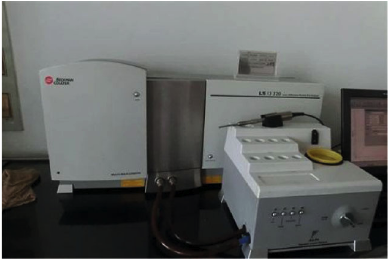
Figure 6: The photograph of laser particle size analyzer.